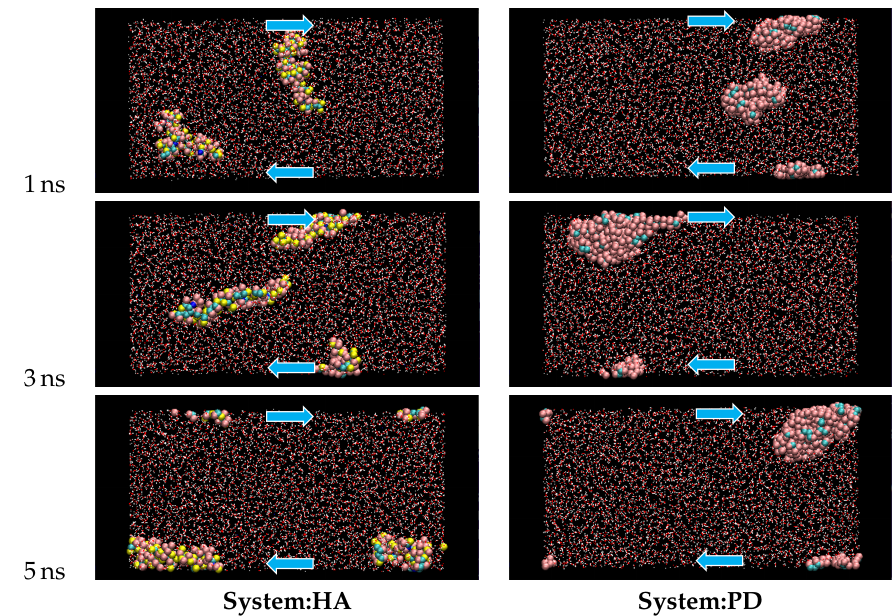
Figure 3. Typical molecular conformation changes during the shear flow simulation; V x = 200m/s. The arrows indicate the shear direction. Water molecules are shown with a wire model to clearly indicate the solute molecules. The indicated time is the elapse after imposing the LE condition.